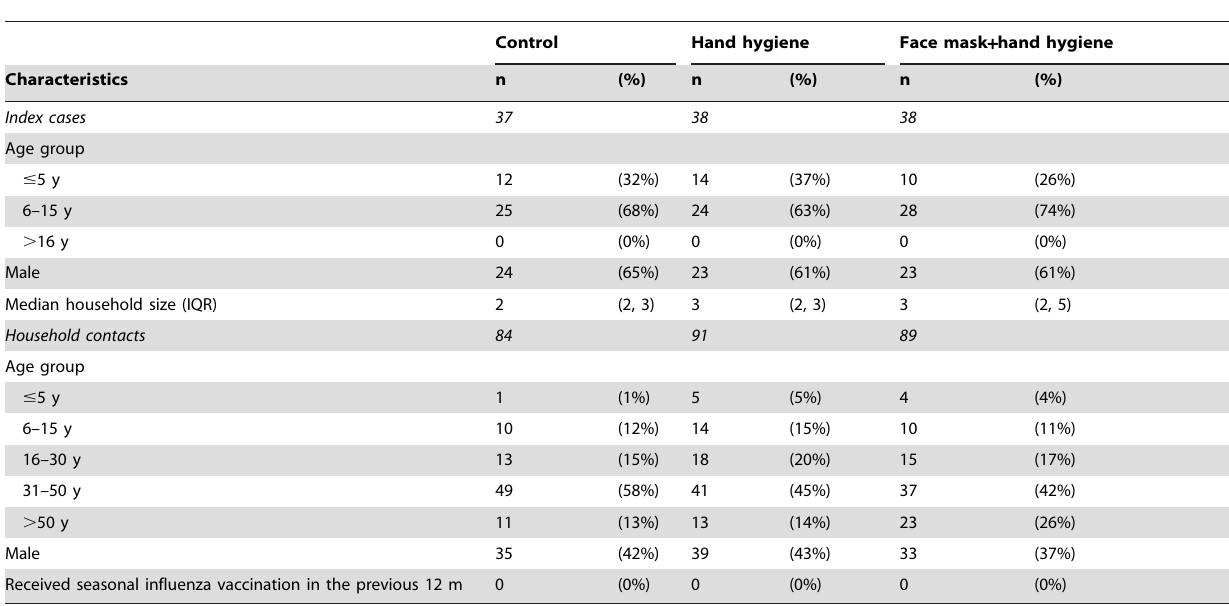
Table 3. Characteristics of index cases with confirmed influenza B virus infection and their household contacts in Bangkok, by intervention